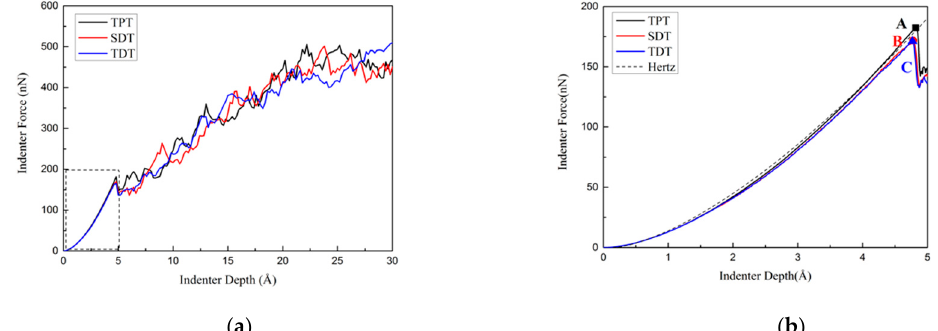
Figure 2. ( a ) Force-indenter depth responses of three different models during nanoindentation. ( b ) Partial enlargement of the elastic stage of the force-indenter depth responses, dash line fitted by Hertz theory.